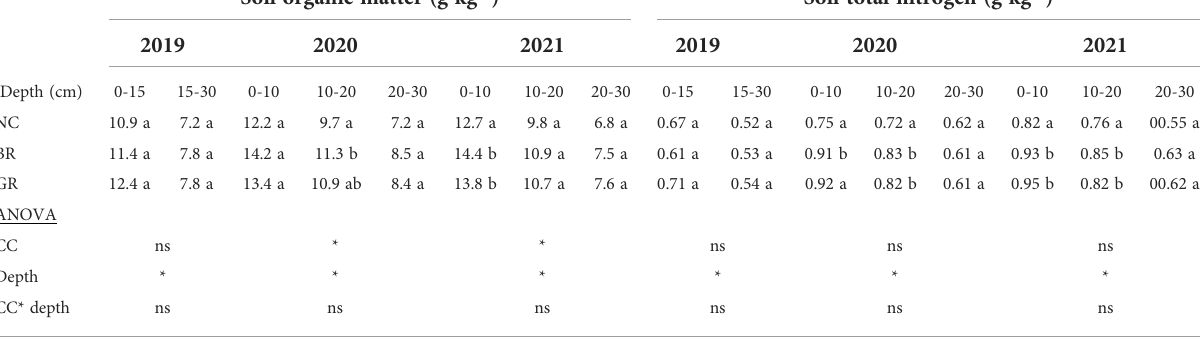
TABLE 3 Mean soil organic matter and total nitrogen at different depths in a 3- year soybean-rye rotation fi eld experiment sampled in spring 2019, fall 2020 and 2021 at Stoneville, MS, USA. Soil organic matter (g kg -1 )